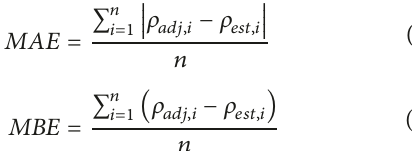
road, as shown in Figure 1(b). When individuals select roads randomly (i.e., no path selection behavior), the crowd flow will evenly split between 𝑜 - 𝑎 and 𝑜 - 𝑏 . In this case, node 𝑎 and node 𝑏 still contribute equally to the population estimation at node 𝑜 . In Figure 1(c), when node 𝑎 becomes more attractive than node 𝑏 , we adjust the distance weight according to the path selection behavior to reflect the attractiveness of the road